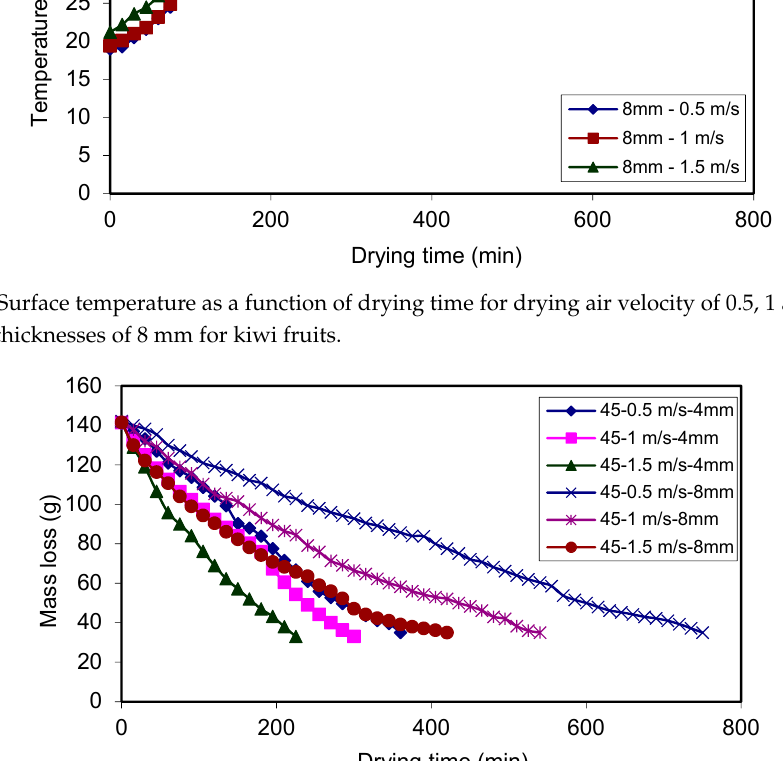
Figure 9. Mass loss of kiwi fruits at different slice thicknesses.